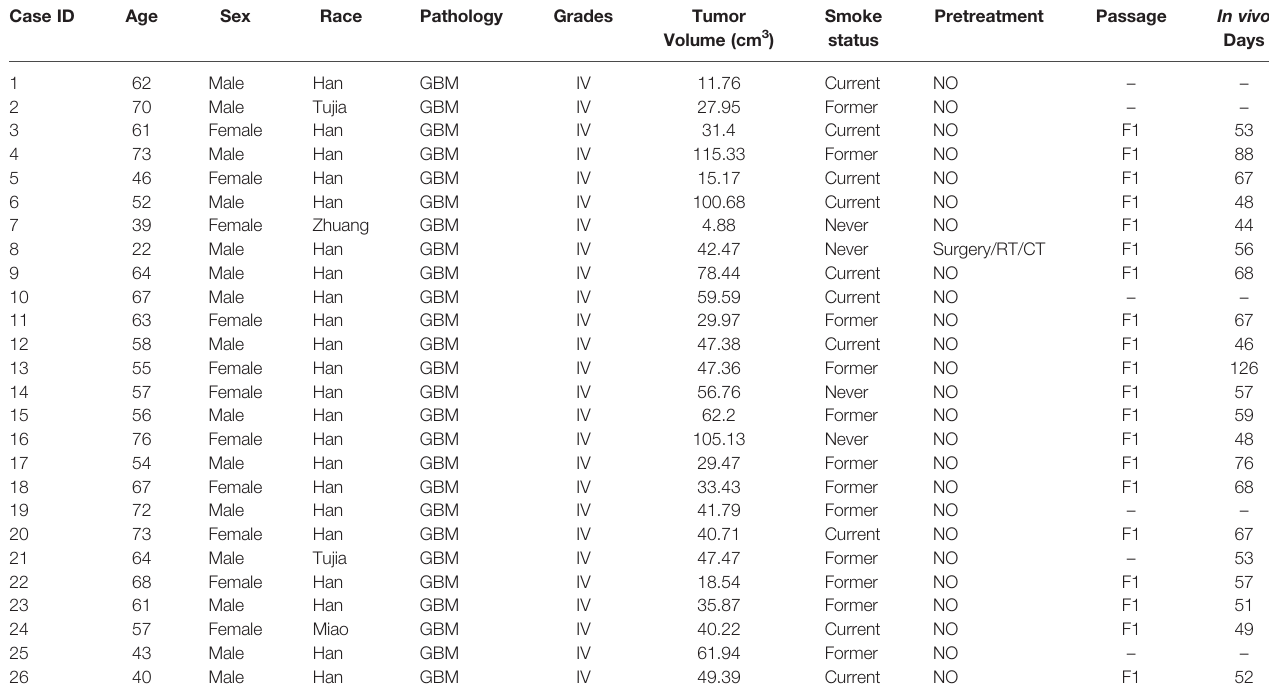
TABLE 1 | The demographic and clinical information for patients of PDOX models. Case